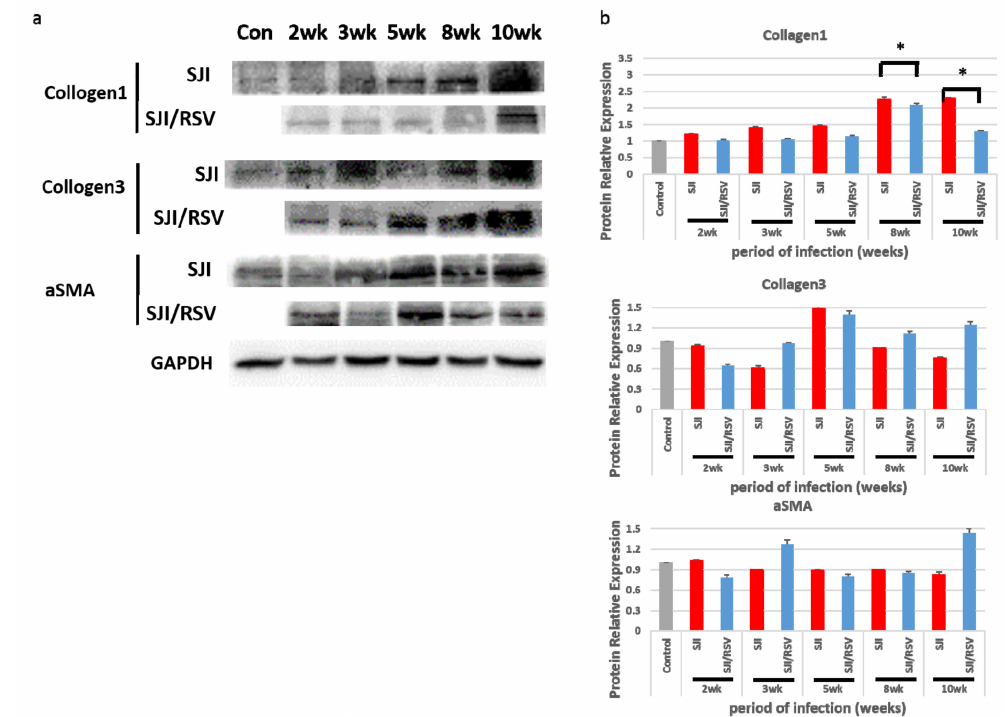
Figure 4. RSV decreases expression of fibrosis-related proteins in the liver tissue of S. japonicum -infected mice. ( a ) Representative images of western blot gels for collagen I, collagen III and α -SMA expression. ( b ) Quantitative changes measured with the ImageJ plugin software. RSV reduced the expression of all three genes compared to the non-treated mice (uninfected mice were used as the normal control group). Results are presented as mean ± SD (n = 5). * p < 0.05, unpaired Student t test. 3.5. RSV Treatment Reduces the S. japonicum Worm Count in Infected Mice